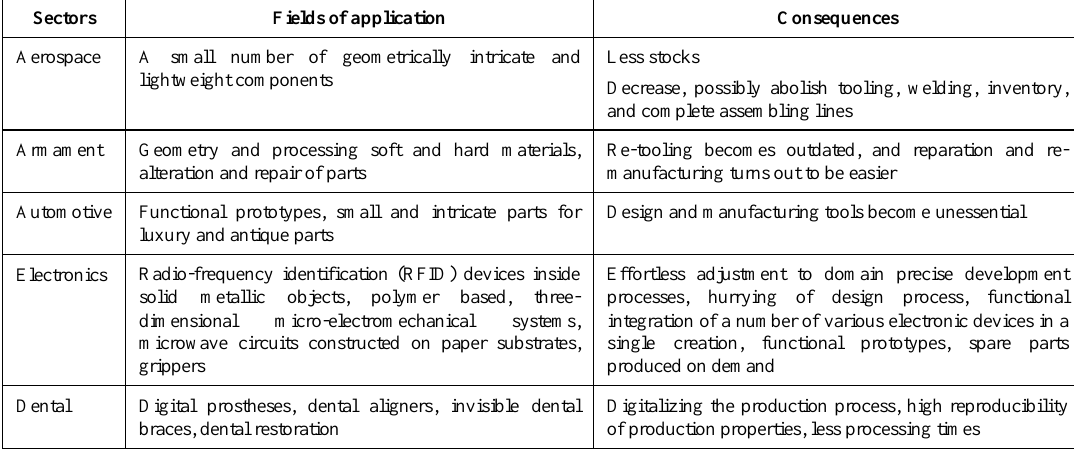
Table 5. Sections of function and the significances of additive